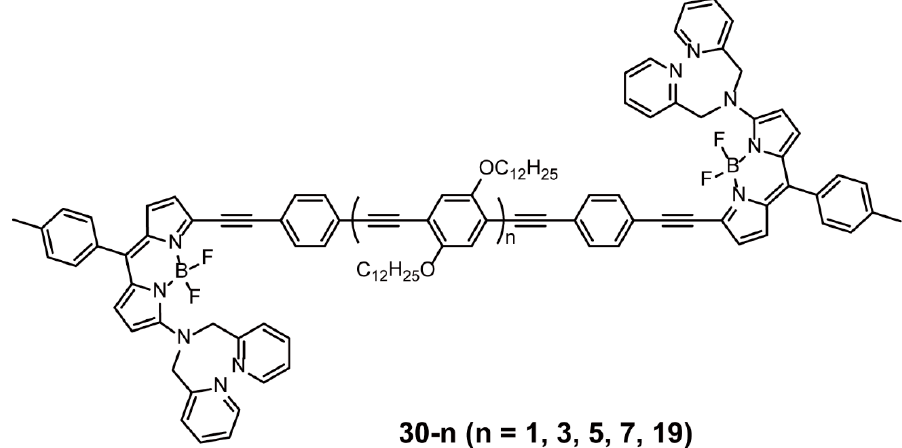
Figure 10. Chemical structure of polymer 30 (Reproduced with permission from Reference [56]. Copyright @ 2011, Elsevier. Reproduced with permission from Reference [57]. Copyright @ 2011 WILEY-VCH Verlag GmbH & Co. KGaA, Weinheim.).